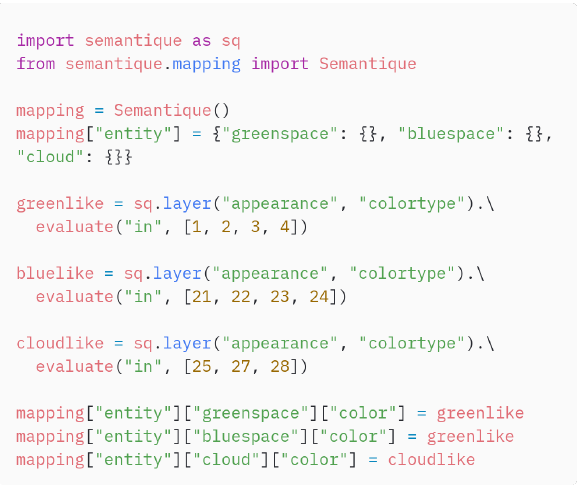
Figure 3. Code snippet for constructing a